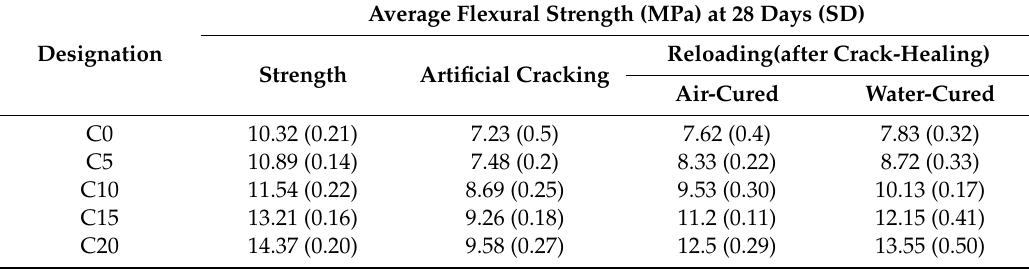
Table 5. Flexural strength regain due to the crack-healing e ff ect of